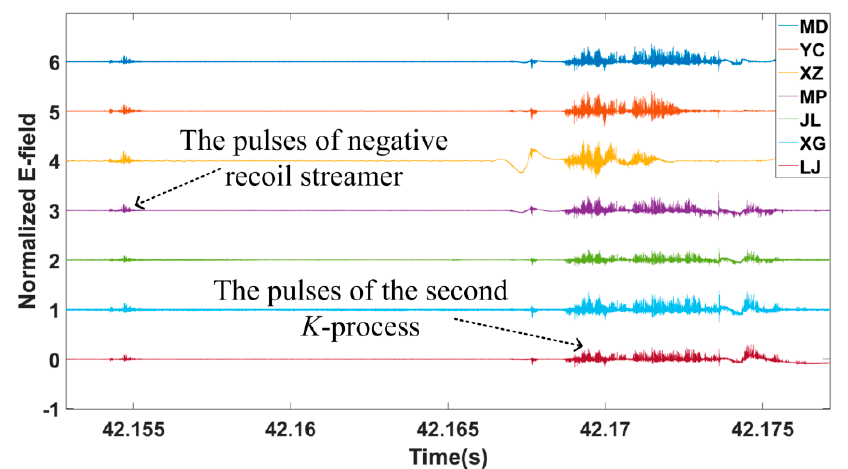
Figure 12. The pulses of the second negative recoil streamer and the second K -process pulses of the negative leader channel.